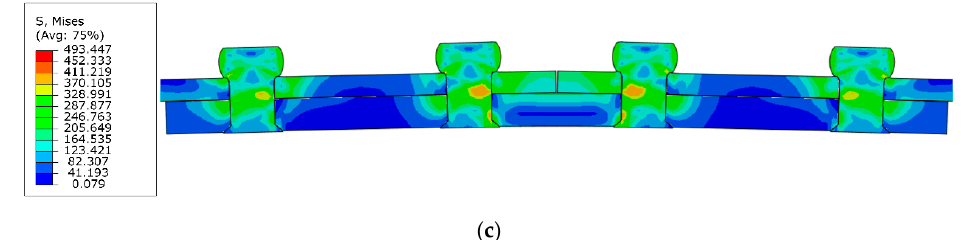
Figure 16. The Von Mises stress of the riveted butt joints under tensile load. The second kind of bending